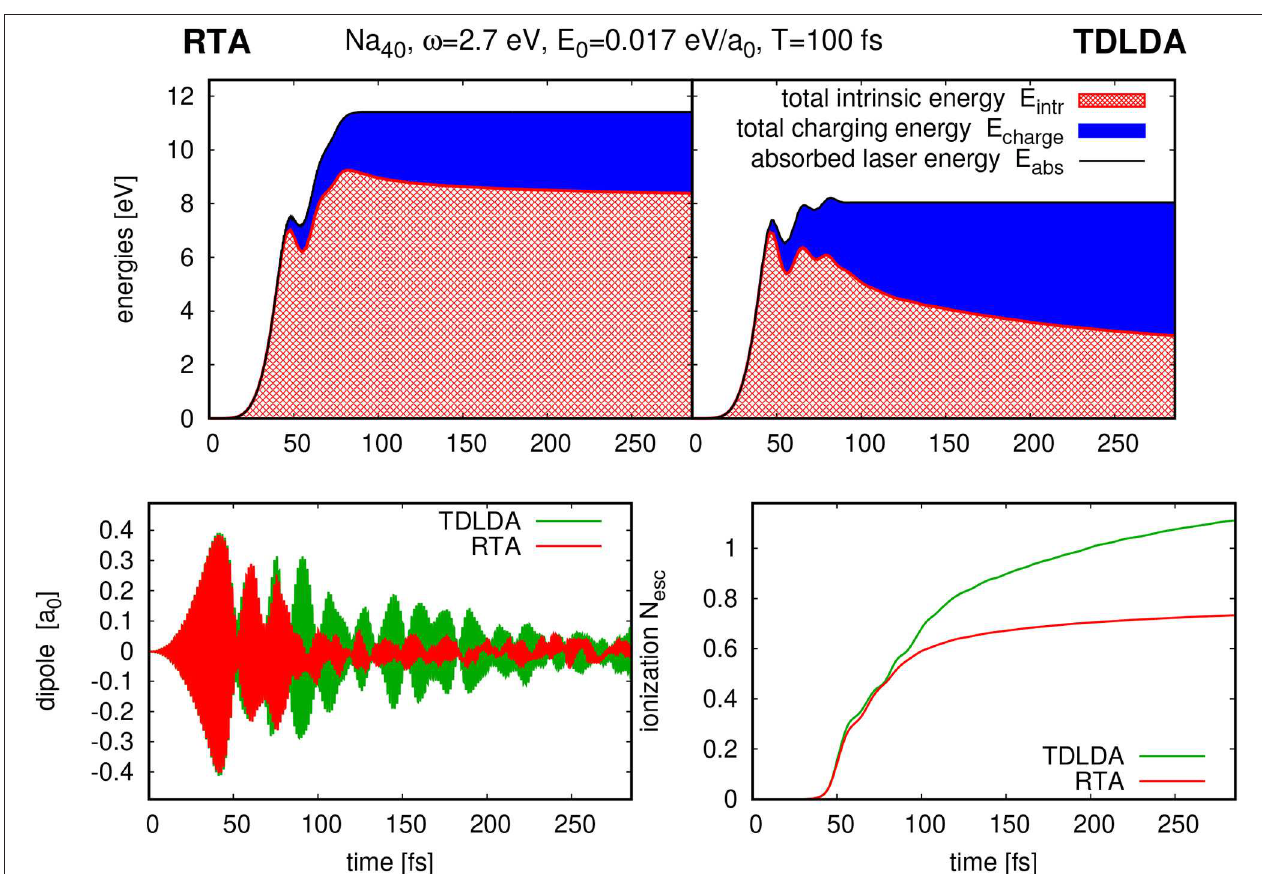
FIGURE 4 | Time evolution of ionization (lower right), dipole moment (lower left), and the various contribution to the energy (upper panels) for the case of Na 40 excited by a laser with frequency ω = 2.7 eV, total pulse length T pulse = 100 fs, and intensity I = 1.3 × 10 10 W/cm 2 . Left upper panels show results from RTA and right upper panels from